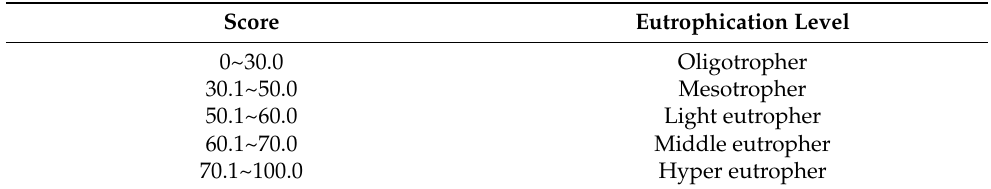
Table 1. Grading and classification